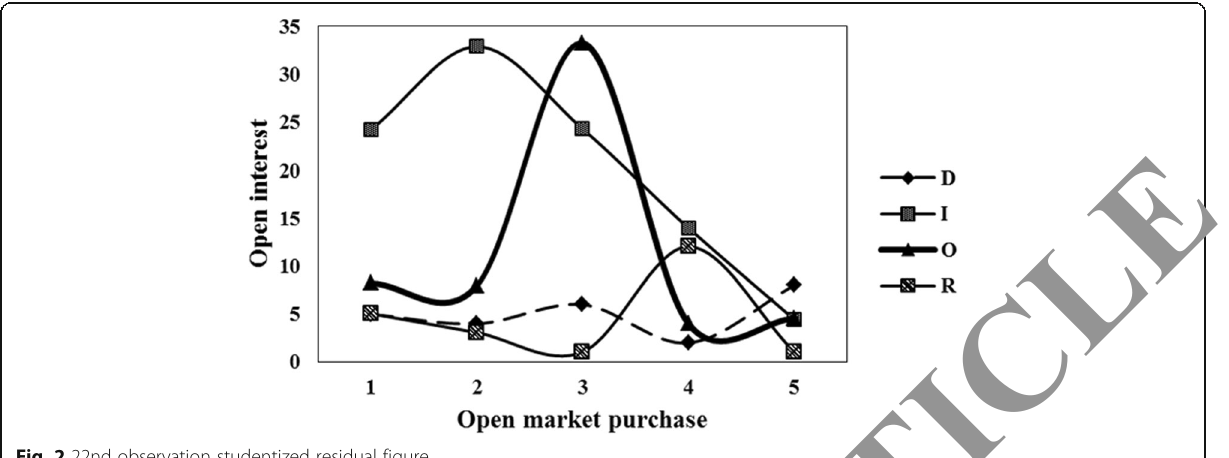
Fig. 2 22nd observation studentized residual